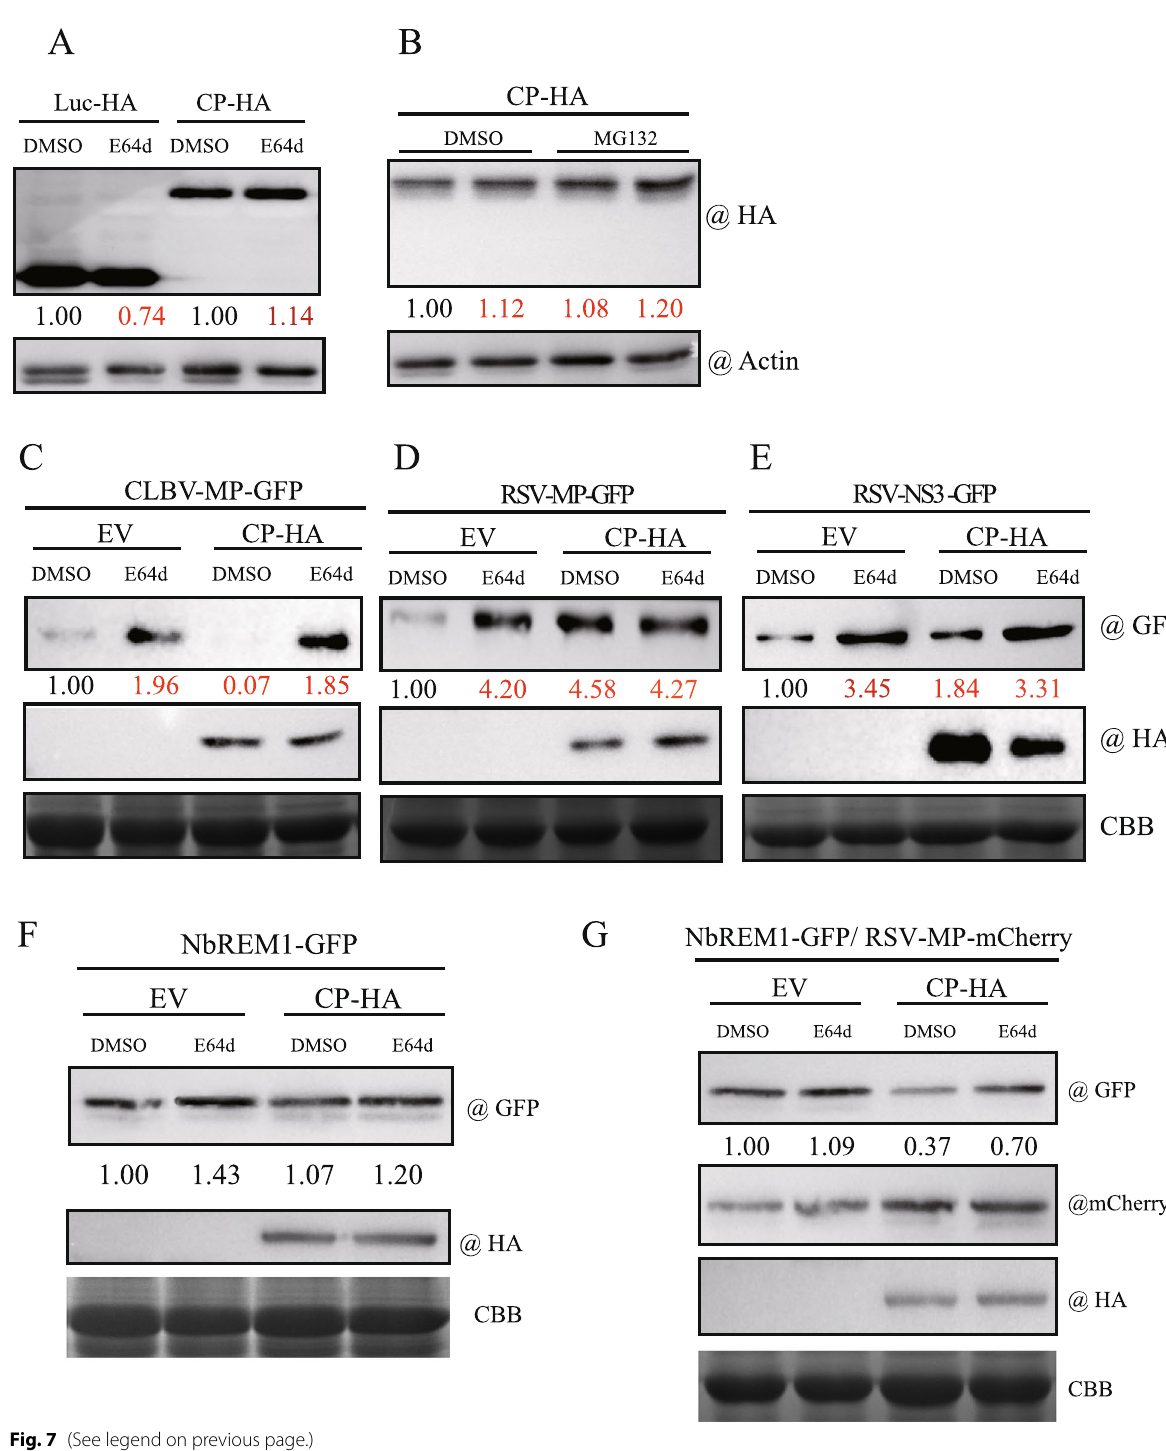
Fig. 7 (See legend on previous